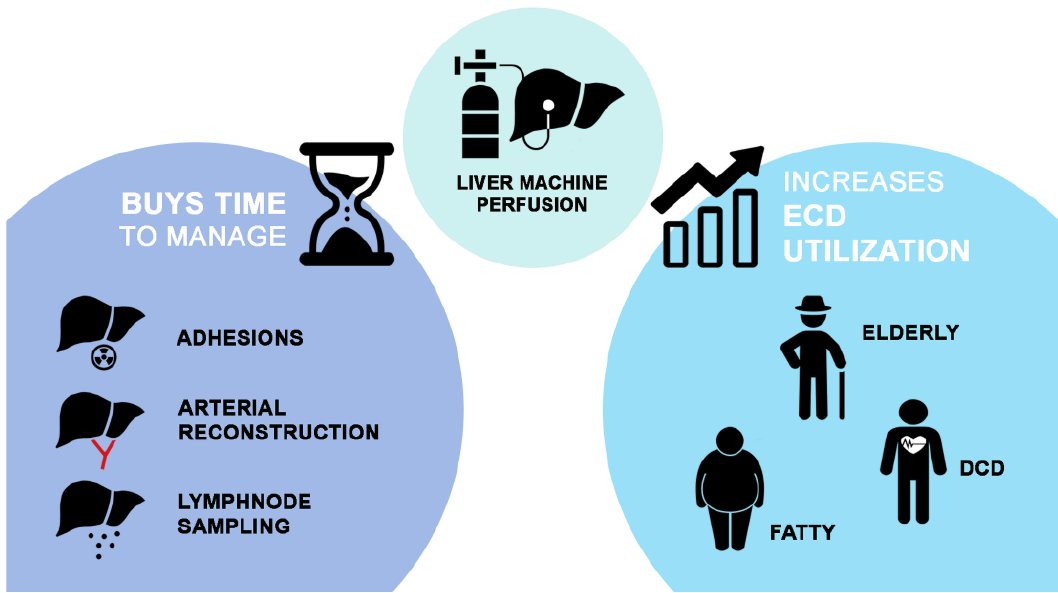
Figure 1. A visual representation of the possible advantages of MP technology in the setting of liver transplantation for perihilar cholangiocarcinoma.